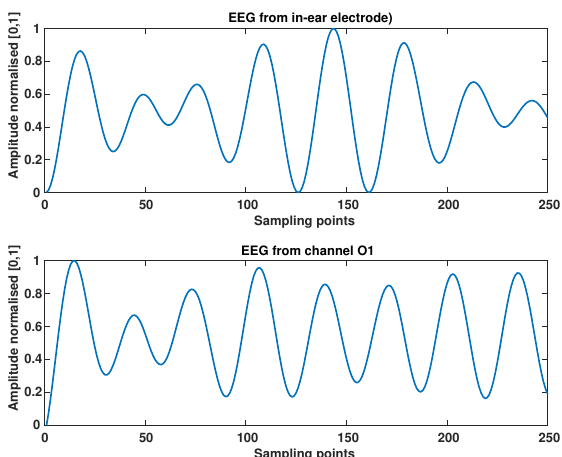
Figure 6. A one second section of EEG waveform acquired simultaneously from the in-ear electrode and occipital channel O1 for stimulus frequency of 7 Hz (filtered from 6 to 8 Hz to clearly show the cyclic information).